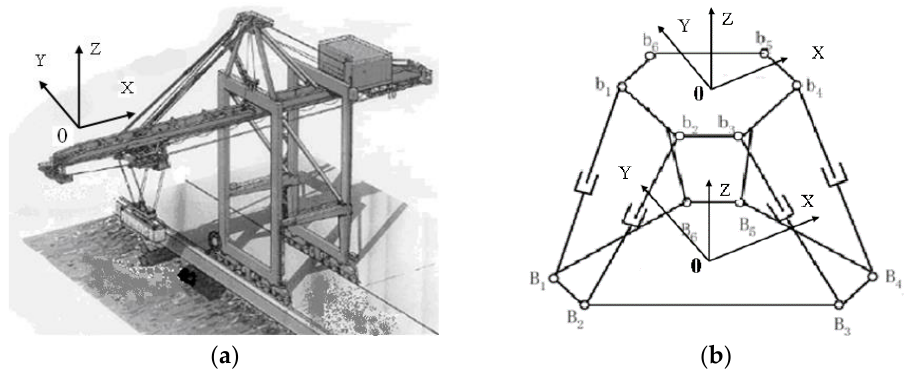
Figure 1. Coordinate system of crane cab and motion platform: ( a ) quayside container crane coordi- nate system; ( b ) coordinate system of the 6-DOF motion platform.